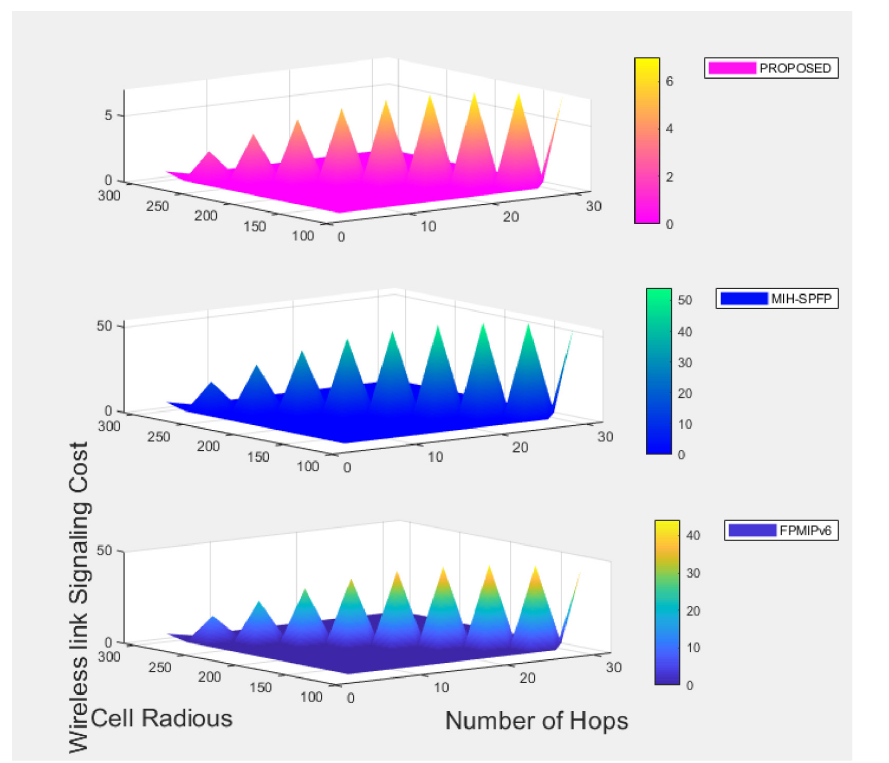
Fig 9. Wireless link signaling cost